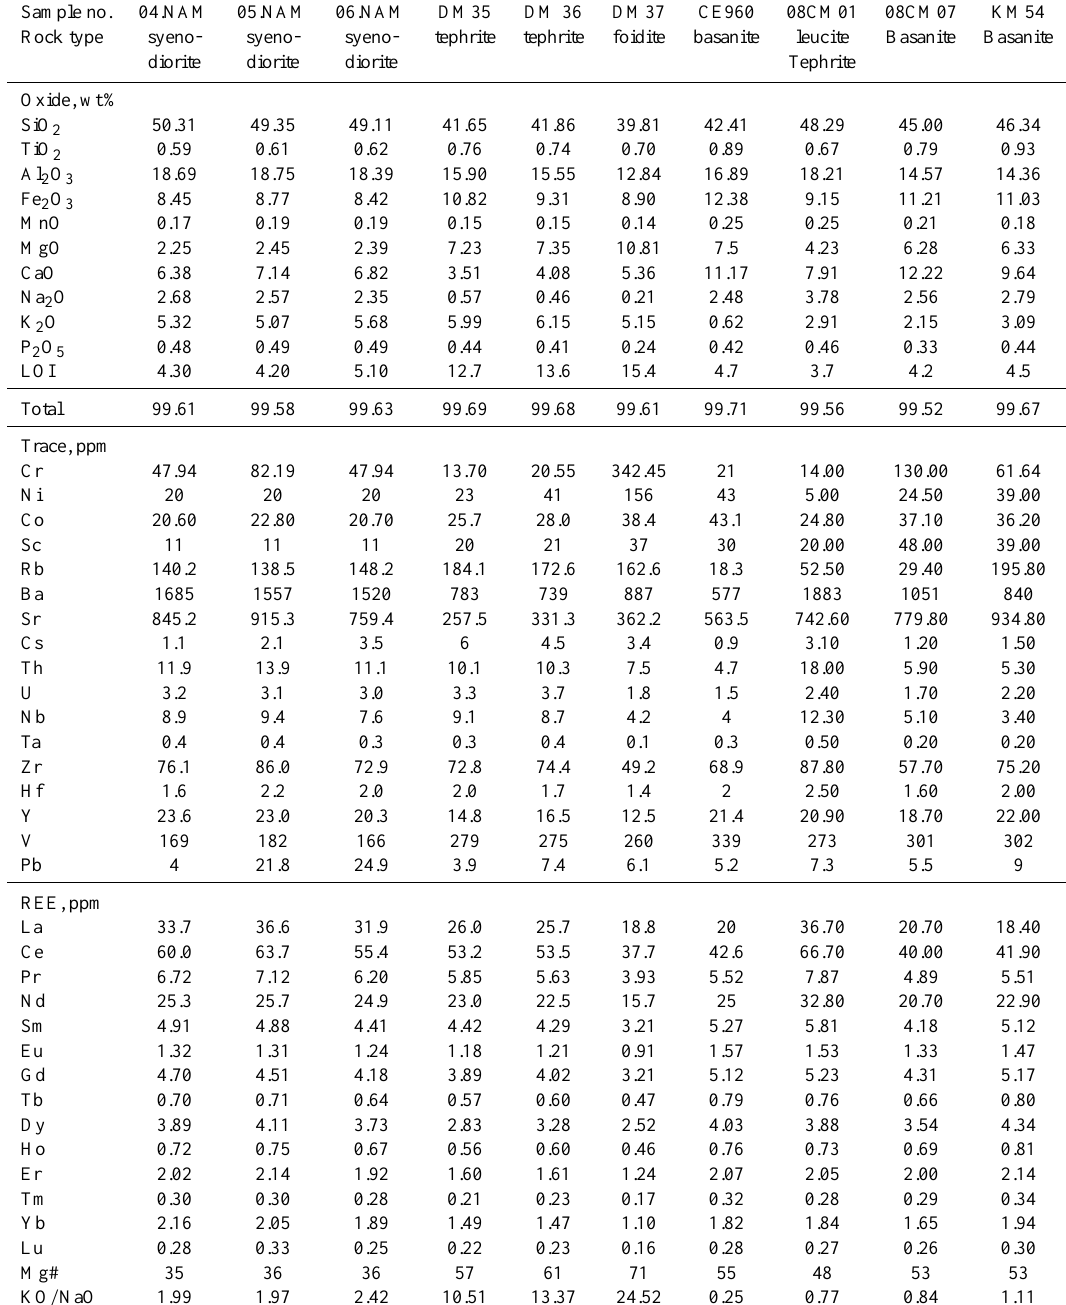
Table 7. Major, trace element and REE data for a select group of island arc volcanic and syenodiorite rocks from the Ankara Mélange. Sample